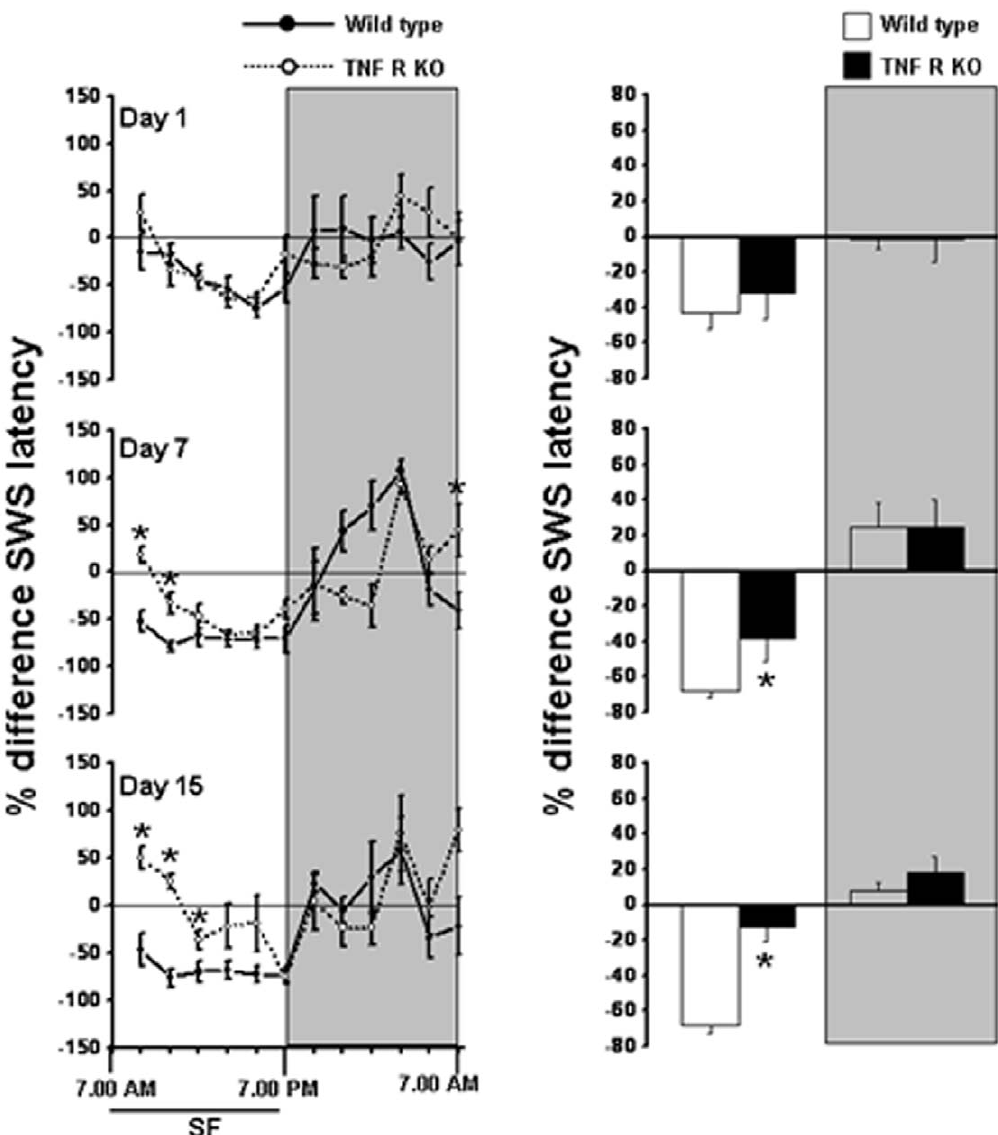
Figure 3. SWS sleep latency in WT and TNF R KO mice. Left panel shows percent differences in SWS latency in WT (solid line) and TNFR KO mice (dashed line) (2 hr bins) on day 1, day 7 and day 15 of SF. Right panel shows total SWS latency during light period and dark period in WT (open bars) and TNF R KO mice (filled bars). Shaded area represent dark period. The black line indicates SF period (7.00 am to 7.00 pm). SF, sleep fragmentation. p , 0.05. *=comparison between WT and TNF R KO during respective post-fragmented